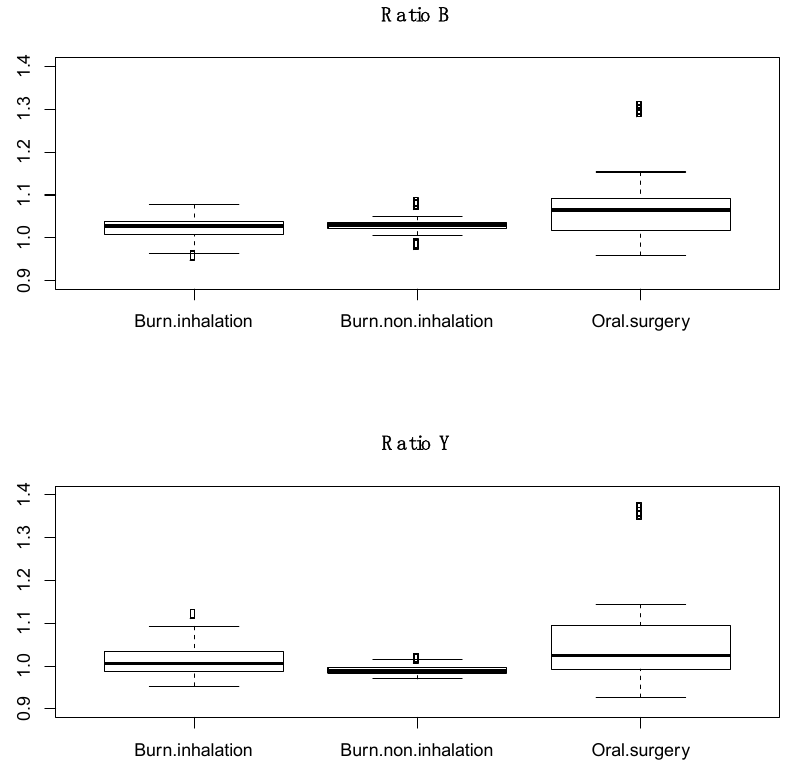
Figure 5. Boxplots of ratio B and ratio Y of trachea from burn subjects with inhalation injury, burn subjects without inhalation injury, and healthy human subjects. Dots in the boxplots are outliers, defined as being 1.5 times the interquartile range beyond the first and third quartiles.